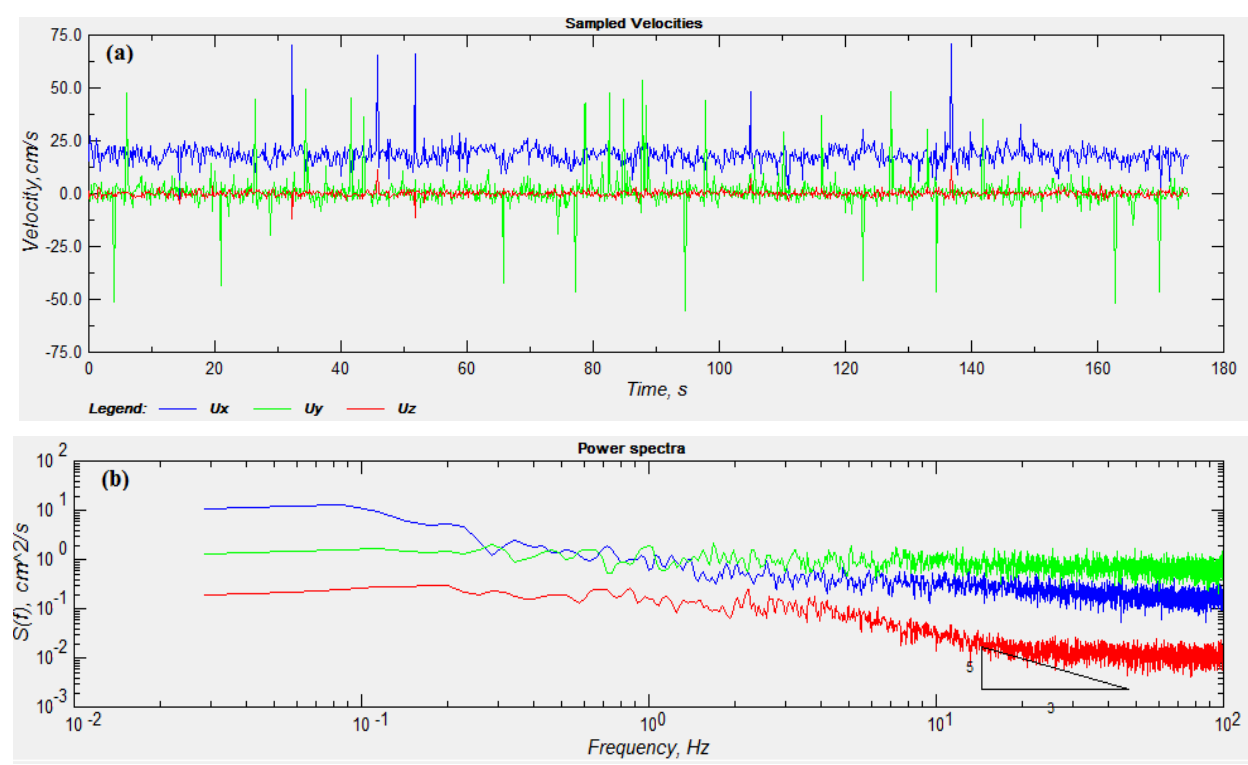
Figure 3. ( a ) ADV sampled velocities (unfiltered ADV data); ( b ) Power spectra of sampled data for no-seepage experiment.